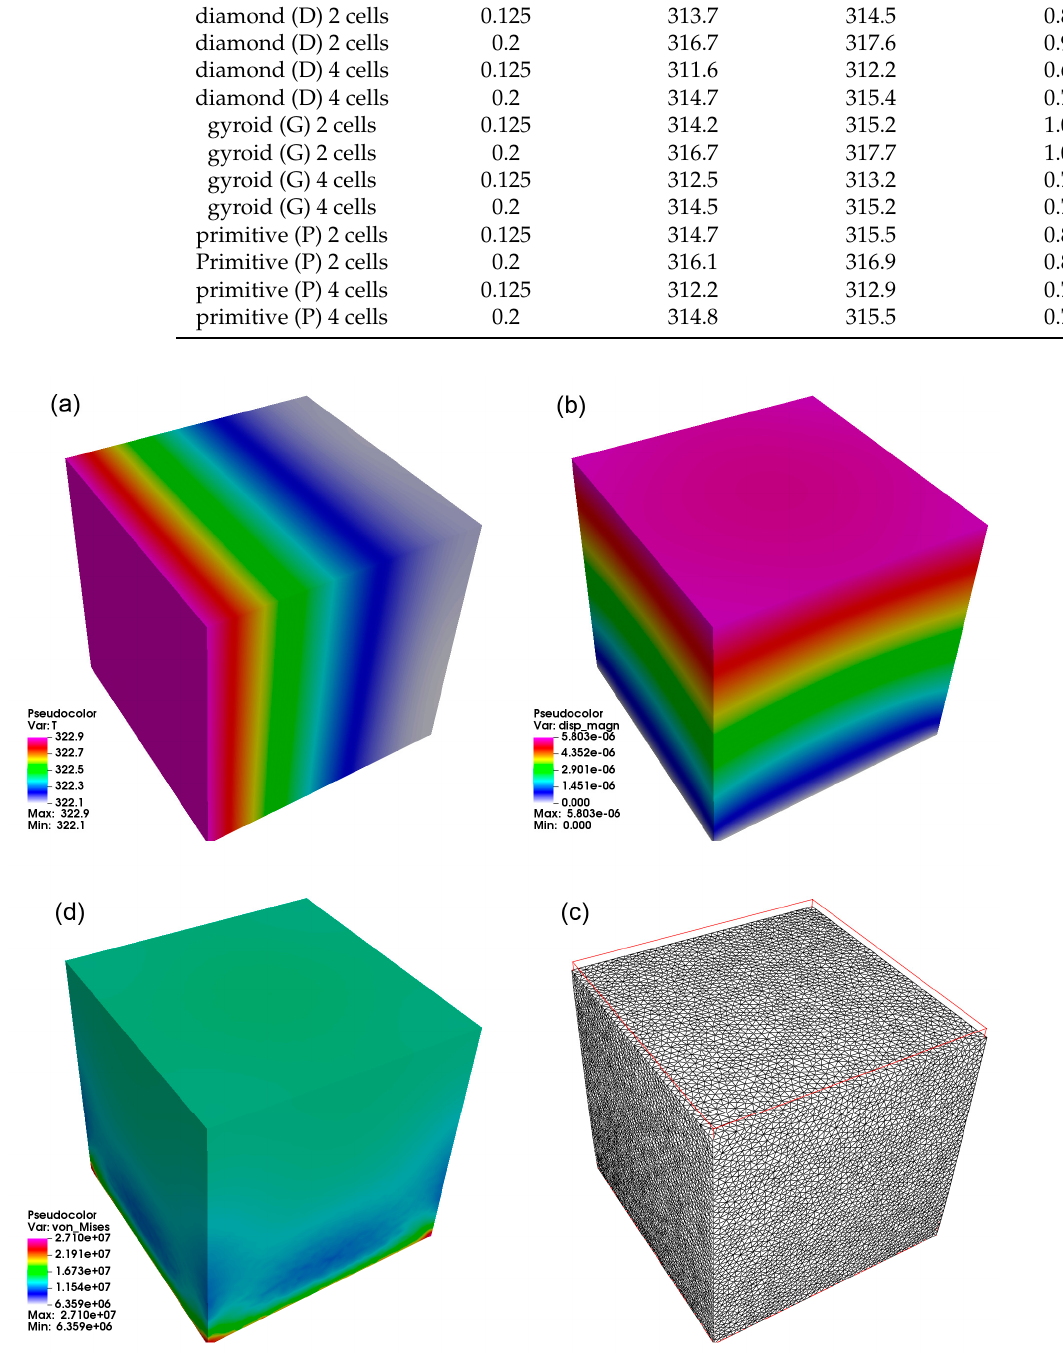
Figure 1. The results of heat simulation after 250 s. Columns from left to right: diamond (D) surface, gyroid (G) surface, primitive (P) surface. Rows from top to bottom: 2 cells, thickness δ = 0.125; 2 cells, thickness δ = 0.2; 4 cells, thickness δ = 0.125; 4 cells, thickness δ = 0.2